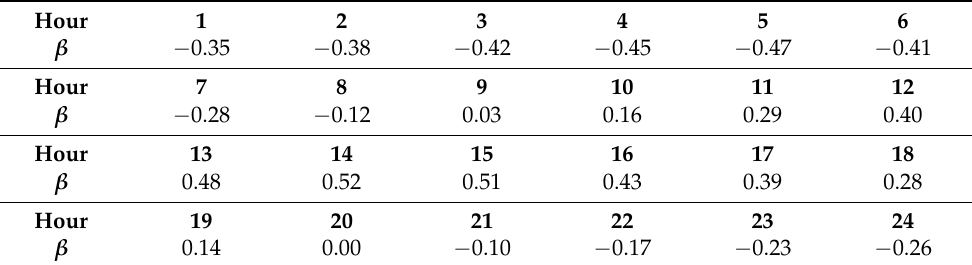
Table 2. Time-by-time variation coefficient of dry bulb